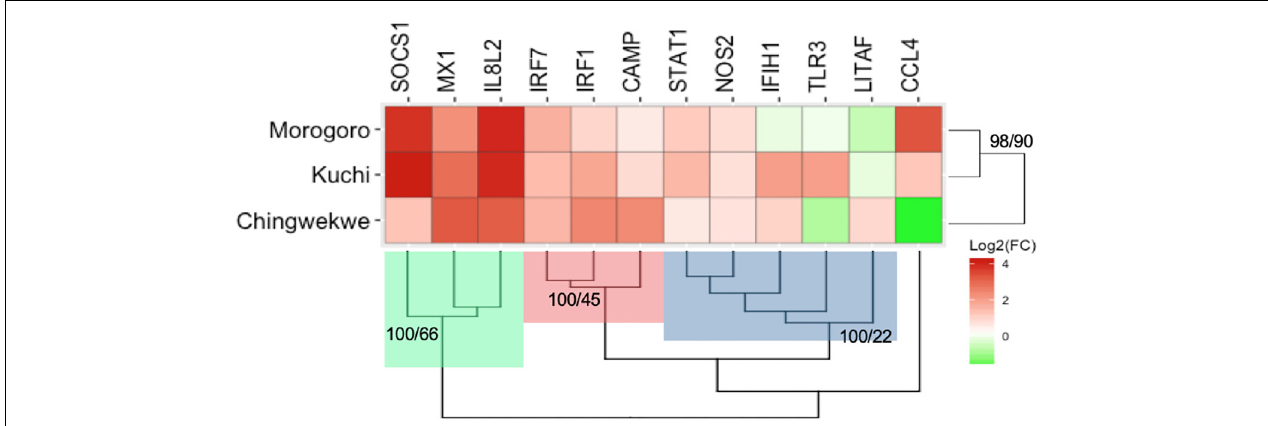
FIGURE 2 | Heatmap and hierarchical clustering of innate immune gene expression profiles of the three Tanzanian ecotypes. The average log2(Fold Change) of the innate immune genes examined is illustrated in the heatmap. The red represents genes that are upregulated and the green represents genes that are downregulated. Hierarchical clustering was performed with the innate immune genes and the ecotypes. The targets clustered into three main groups, Cluster 1 (green), Cluster 2 (red), and cluster 3 (blue). The ecotypes group by the Morogoro Medium and Kuchi clustering together and with the Ching’wekwe as an outlier. The AU and BP values are shown at their respective nodes (all values are significant AU > 95).